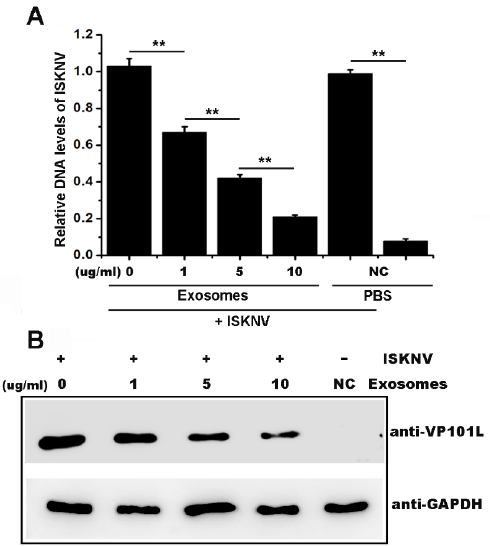
Figure 1. Isolated exosomes from mandarin fish serum. ( A ) Schematic of the generation of purified serum-derived exosomes from mandarin fish by using differential centrifugation. ( B ) Purified exosomes (right) from mandarin fish serum were analyzed using Western blot with antibody directed against CD63, TSG101, and HspA8. The normal untreated mandarin fish serum (left) was used as the control. ( C ) Transmission electron microscopy observations of the purified exosomes from serum. ( D ) Confocal microscopy assay showed that the exosomes were internalized by MFF-1 cells after incubation with PKH67-labeled exosomes for 2 h.